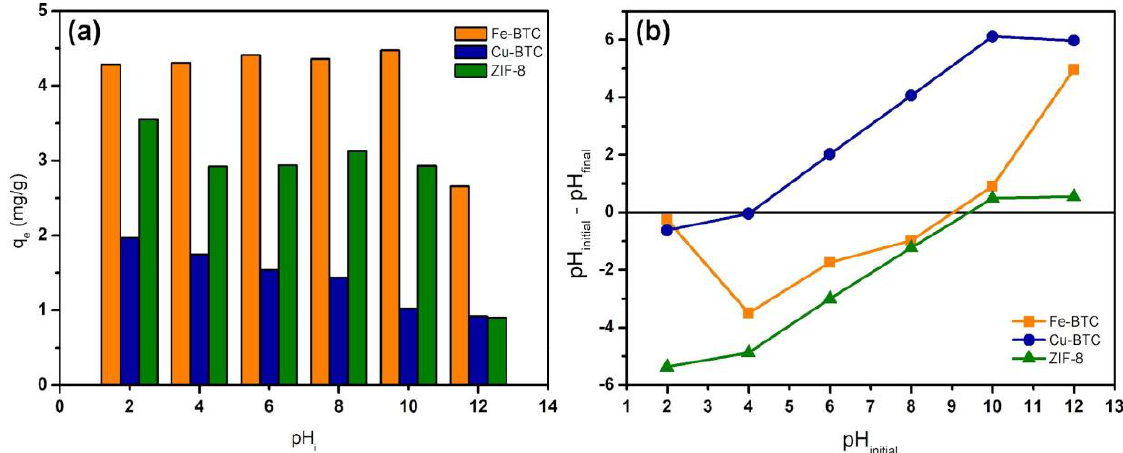
Figure 7. ( a ) Initial pH’s (pH initial ) effect on equilibrium adsorption capacity ( q e ); and ( b ) experimental results of (pH initial − pH final ) vs. pH initial curves used to determine pH PZC of the MOFs.